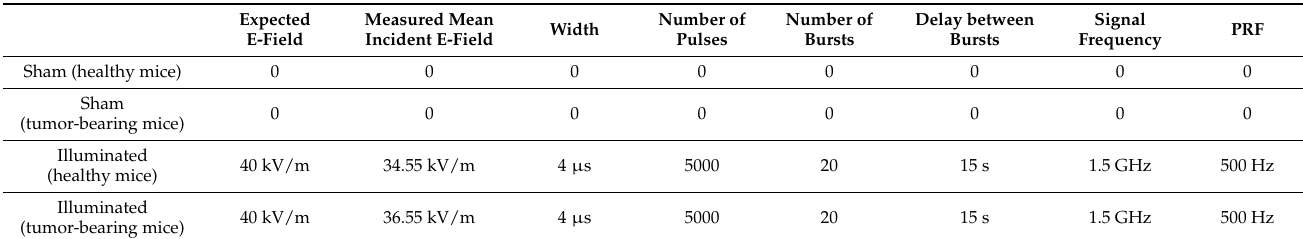
Table 2. Electromagnetic parameters applied in field experiments for narrow-band (NB) illuminations of healthy and tumor-bearing mice (N = 10 mice/group).